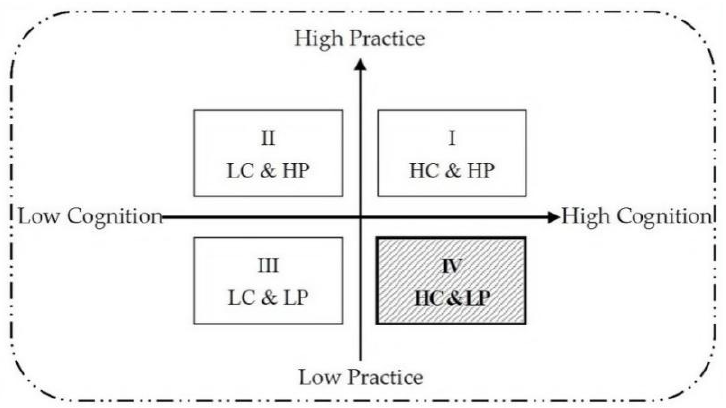
Figure 4. Quadrant diagram of the relationship between cognition and speaking practice of class- room silence.